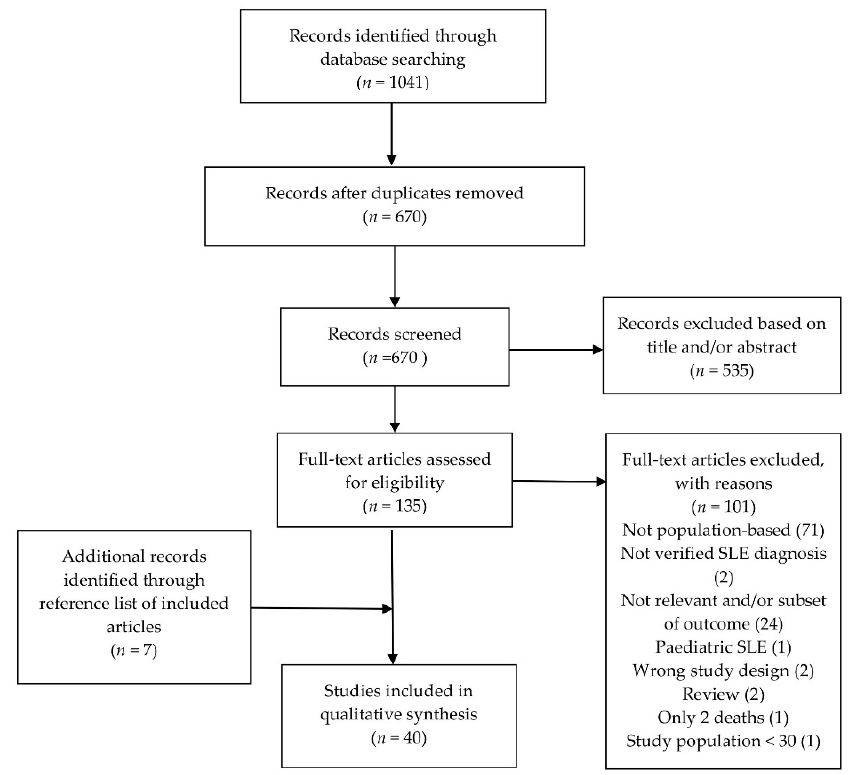
Figure 1. Flowchart of literature search and study inclusion. Studies identified through MEDLINE (Ovid) and Embase (Ovid) through 25 June 2021.